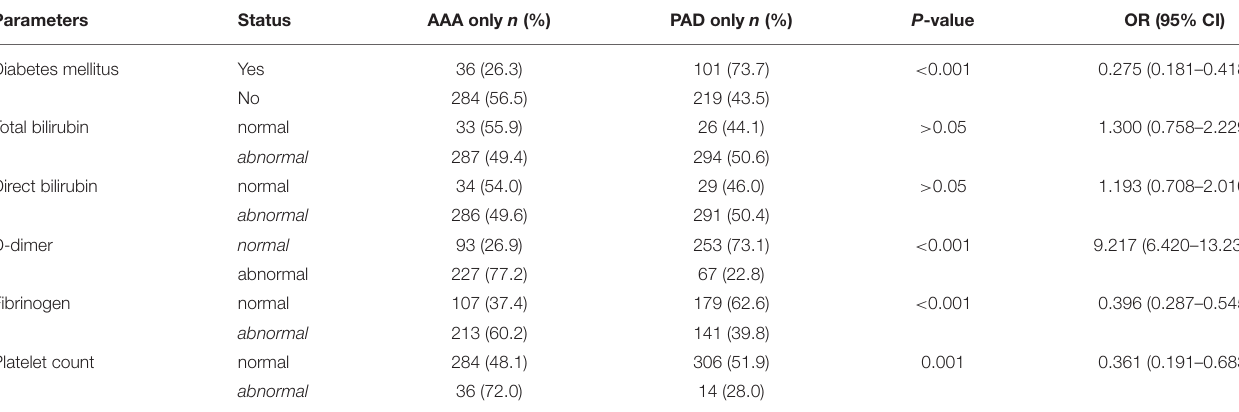
TABLE 3 | Differential distribution of clinical and blood laboratory test parameters in AAA only and PAD only group. Parameters